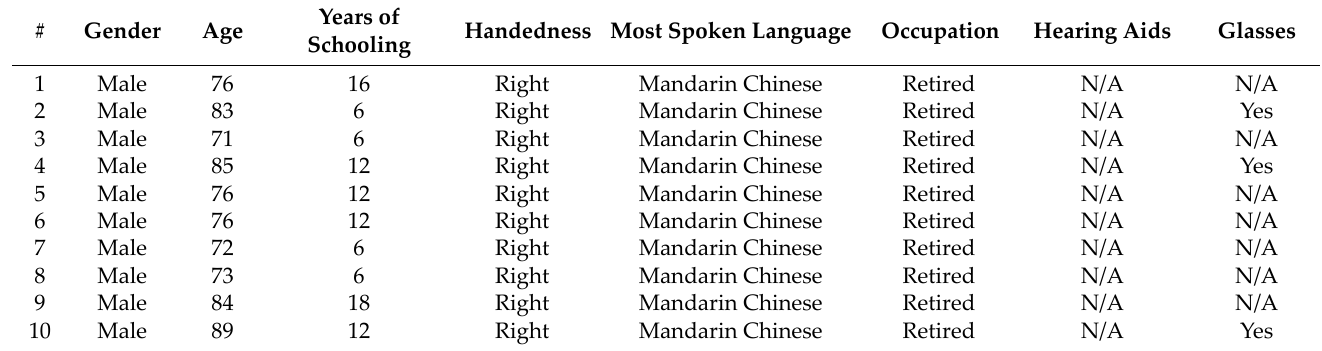
Table 1. Demographic Characteristics of 10 Core HOAs.